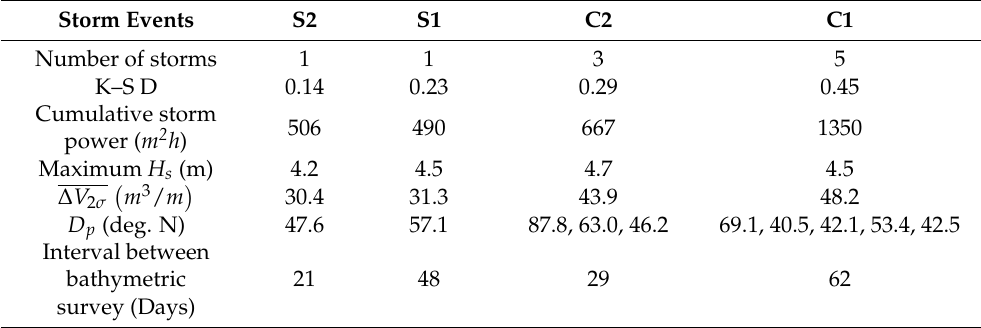
Table 3. Comparison between model sensitivity based on K–S D and other factors based on observations.